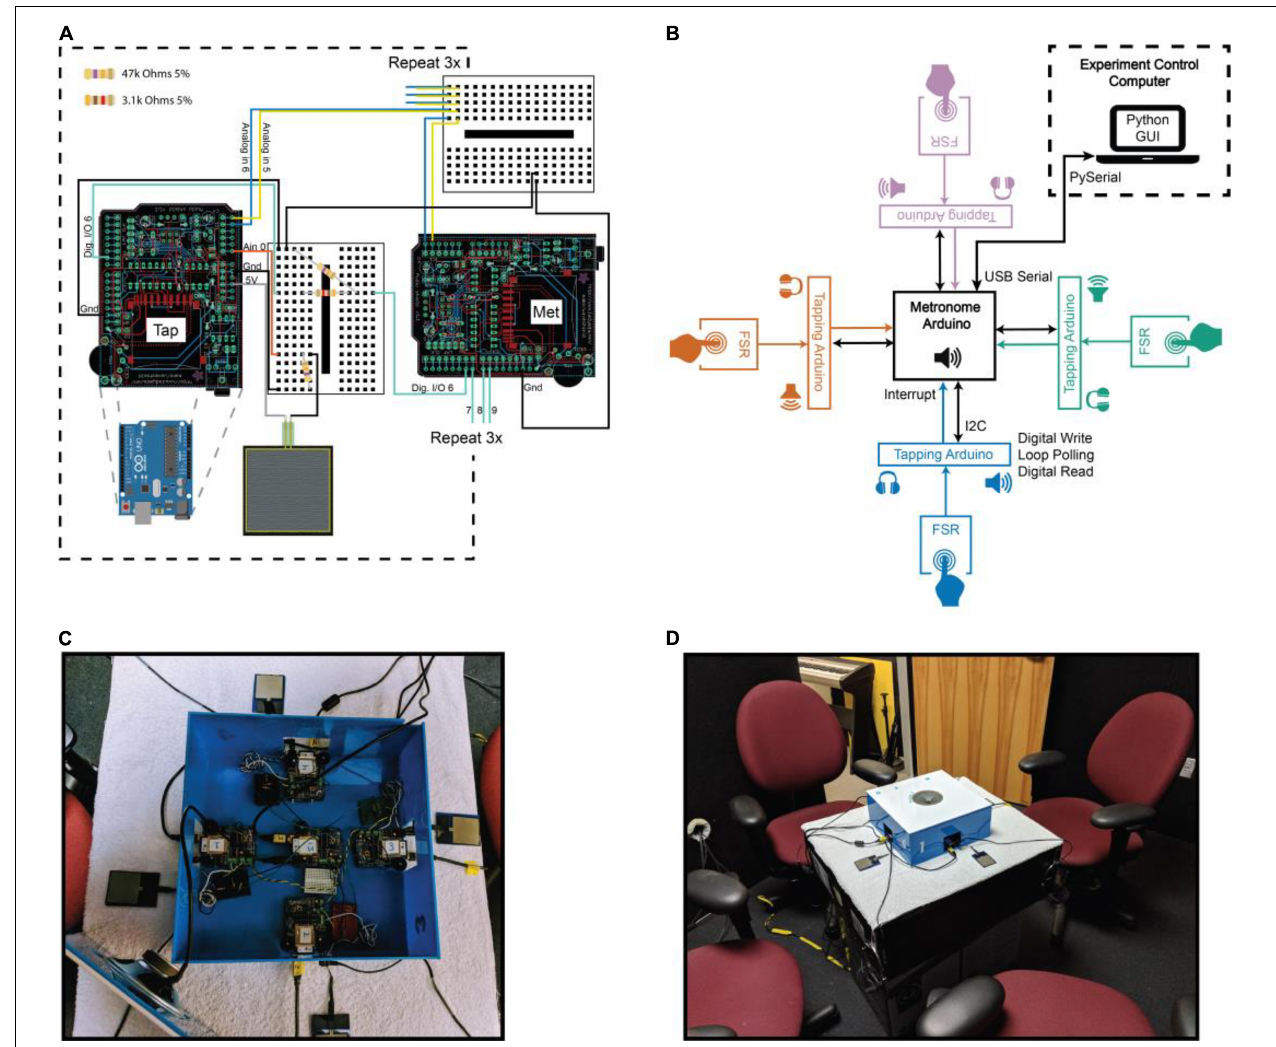
FIGURE 1 | Overview of the GEM system. (A) Wiring diagram illustrating the connections between one tapping device (Tap) and the metronome (Met). Note that we repeat these connections three times (indicated by the dotted black box) to arrive at our 4 Tapper + metronome system. Note also that the connections from all Adafruit Wave Shields (v1.1) depicted here in black carry through to the Arduino Uno boards underneath them to which they are attached, indicated by the dotted gray lines connecting the blue Arduino Uno (bottom left) to the Wave Shield. (B) Schematic of all devices comprising the multi-person adaptive metronome and their means of communication. The metronome Arduino can be in either an “idle” or “run” state. In the idle state, the Experimental Control Computer (ECC; housed in a separate experiment control room, represented by dotted black box) can set experiment parameters on the metronome Arduino, which in turn sets parameters on the tapping Arduinos. Upon receiving the message from the ECC to start a trial, the metronome Arduino is in a constant loop of producing metronome tones according to our adaptive algorithm, registering participant taps, and sending data packets to the ECC. The tapping Arduinos are constantly polling, reading the value of the FSR input pin. When the FSR pin exceeds a specified threshold (a tap occurs), a digital output pin is pulsed on, resulting in the triggering of an interrupt on the metronome Arduino. Participants can hear the sound of their own tap through headphones, speakers, or not at all. The metronome is always heard through a speaker. (C) A photo of the system used in these experiments. (D) The view of our multi-person adaptive metronome, from the participants’ perspective. The speaker in the top center of the box played the tones from the metronome (all Experiments). During experiments in which participants could hear the sound produced by their own tap, they used headphones, which can be seen hanging from the side of the table. During Experiment 5, when participants could hear everyone in the group, we placed an additional speaker to the left of each tap